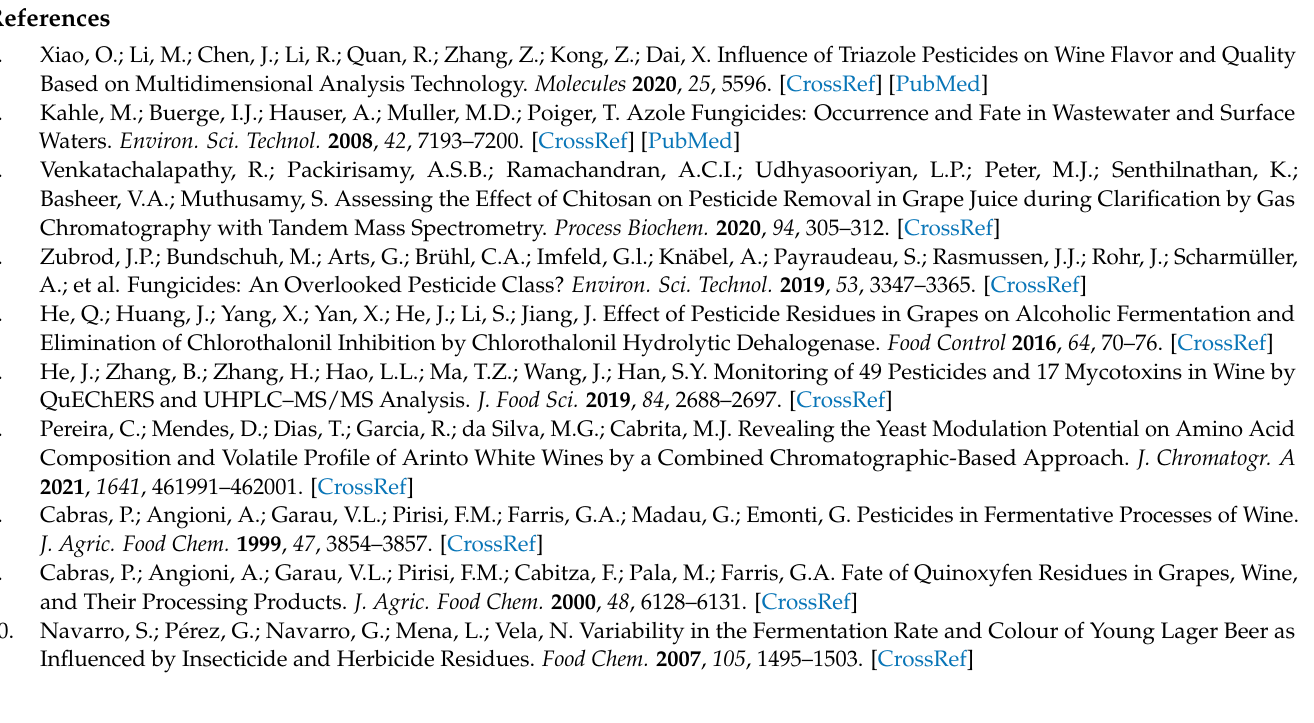
Table S1: Composition of the wine substances determined by GC-MS